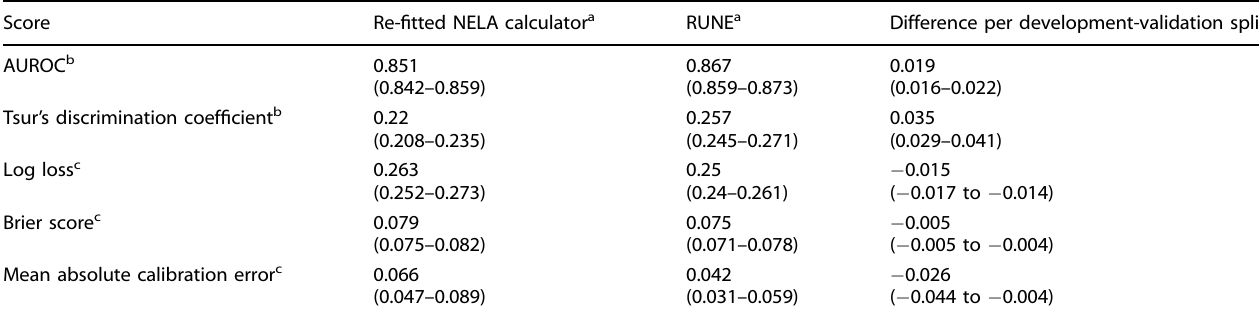
Table 2. Performance of RUNE and the re- fi tted NELA